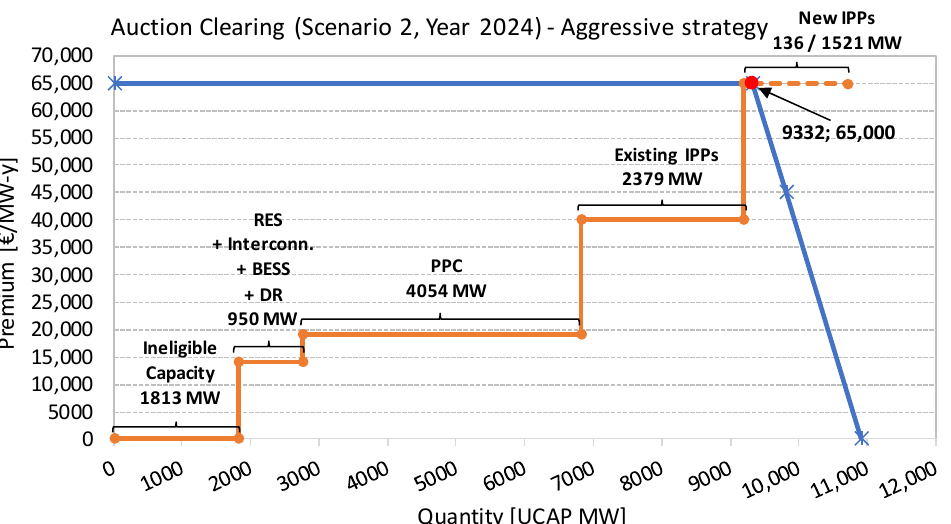
Figure 9. Auction clearing (Scenario 2, Year 2024)–Aggressive strategy.